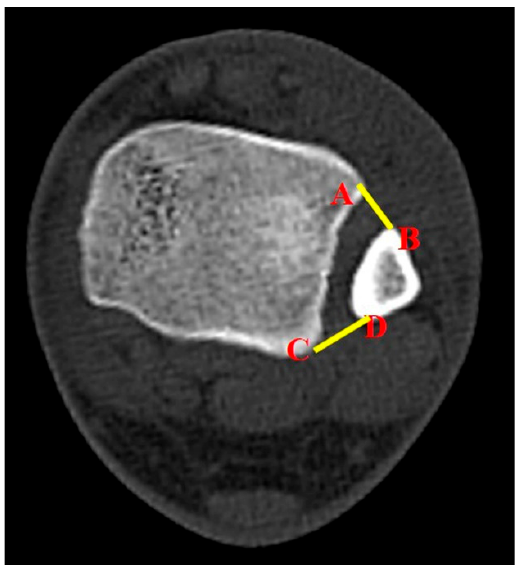
Figure 2. The surface area of syndesmosis, which was measured as a new parameter between four anatomic landmark points on the axial CT image; the points that link the anterior colliculus of the tibia ( A ), the most anterior aspect of the fibular ( B ), the posterior colliculus of the tibia ( C ), and the most posterior aspect of the fibular ( D ).